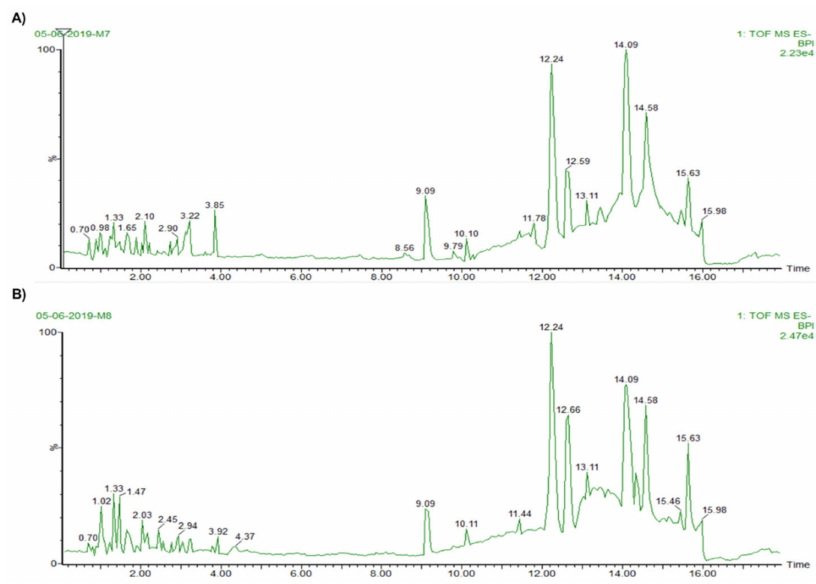
Figure 3. Chromatograms of the crude homogenates from Anemonia sulcata with ( A ) and without ( B ) its